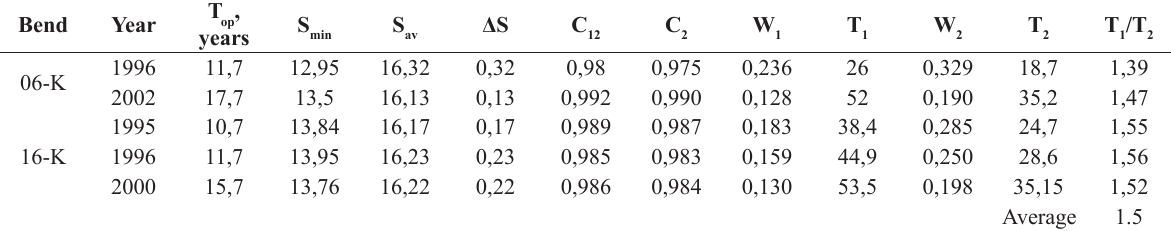
Table 8. FAC rate and residual lifetime for bends without taking (9) into consideration and with correction coefficients (1). Bend